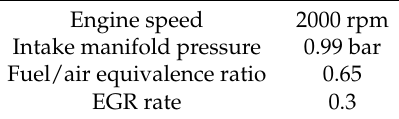
Figure 6. Measurements of the center of combustion COC depending on SOI and DOI for two different operating points. The operating point used for the identification (Table 2) is shown in blue, the corresponding transformation is shown in green, while the alternative operating point specified in Table 3 is shown in red. Table 3. Alternative operating